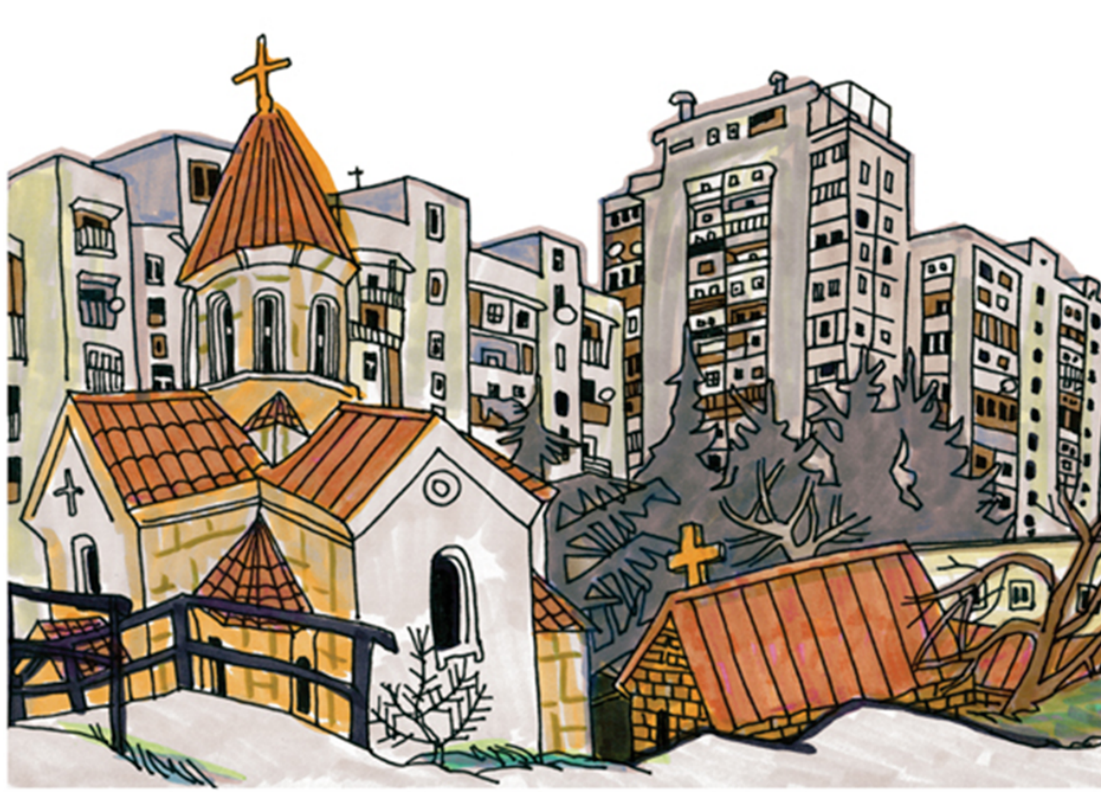
Figure 1 Victoria Lomasko, A Trip to Minsk, the part of the book The Last Soviet